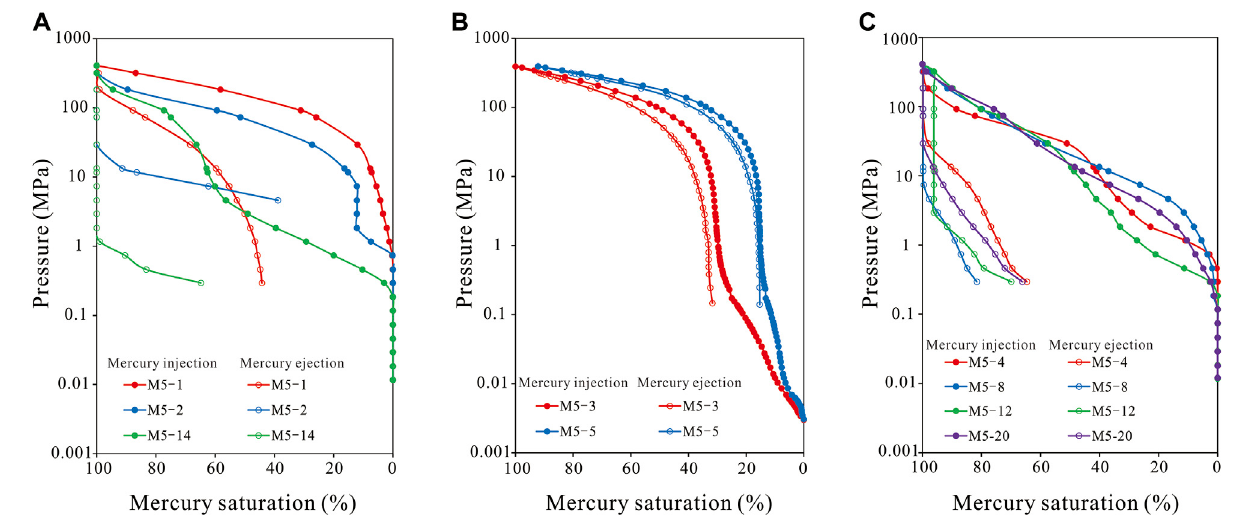
FIGURE 4 | High pressure mercury intrusion curves of typical samples collected from the Shan 2 Member. (A) Shale; (B) Coal; (C) Tight sandstone.